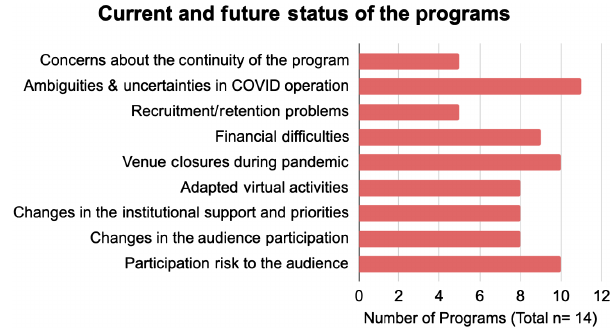
FIG. 1. Counts of programs in our sample whose lead facil- itators reported concerns about their current and future